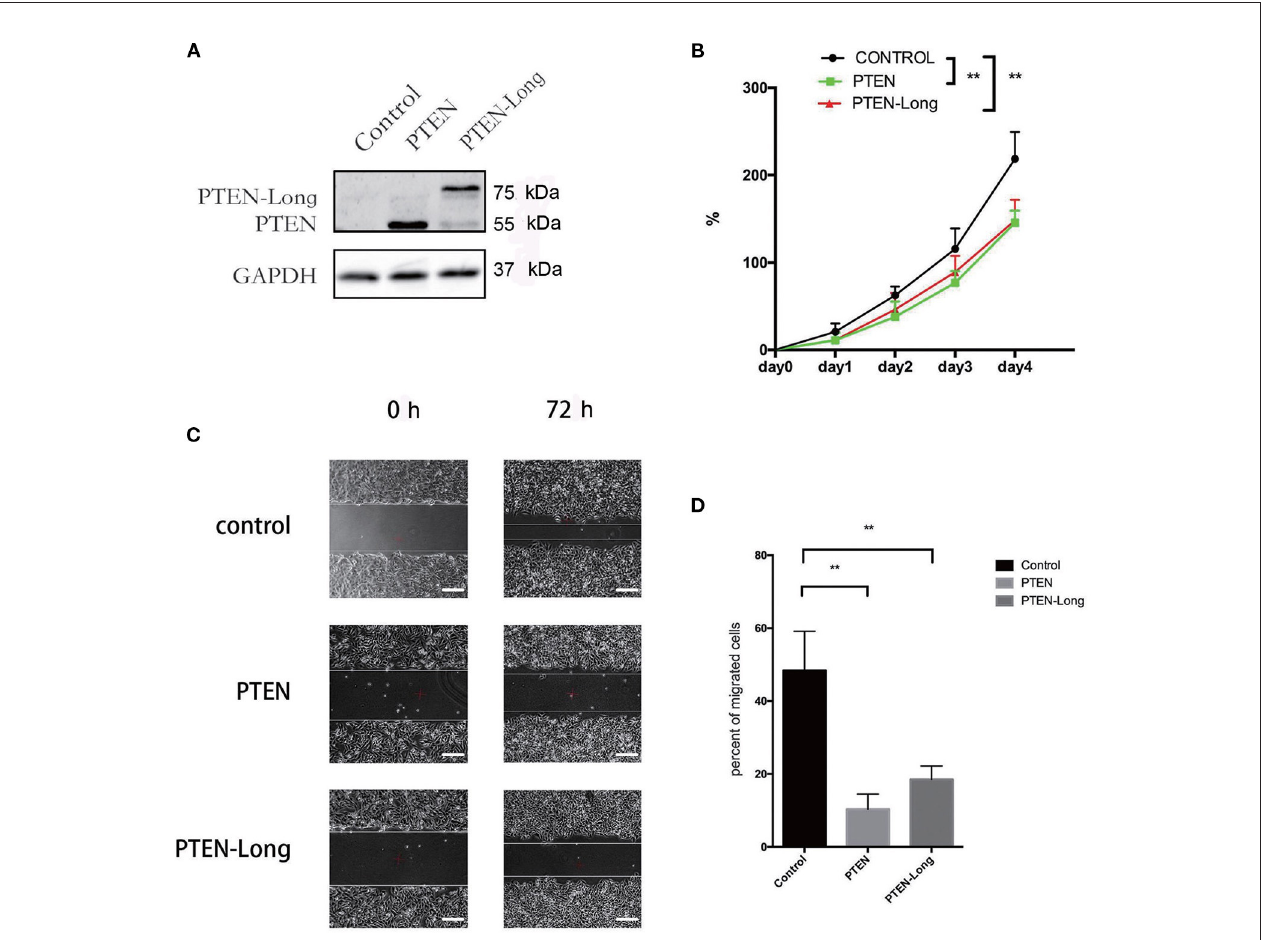
FIGURE 2 | PTEN-Long inhibits cell proliferation and migration. HepG2 cells were selected for at least 2 weeks by incubation with 400 µ g/mL G418 after transfection. (A) Western blot analysis of lysates prepared from HepG2 cells. (B) Of cell proliferation analysis by MTT assay (** P < 0.01). (C) Cell migration analysis by scratch assay. Scale bar = 200 µ m. (D) ImageJ analysis of the invaded area (** P < 0.01).